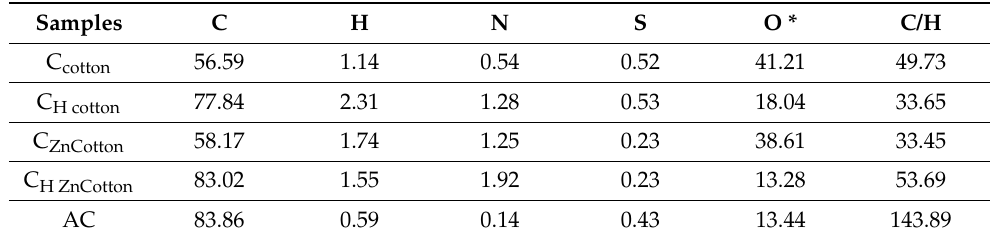
Table 1. CNHS elemental analysis of the used biochars and